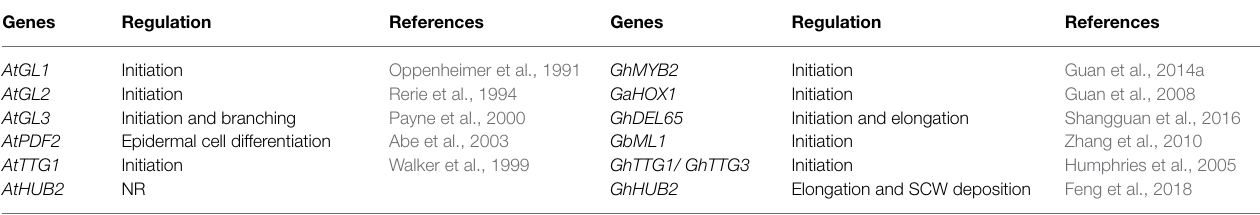
TABLE 1 | Functional homologous genes related to Arabidopsis trichome and cotton fiber patterning.